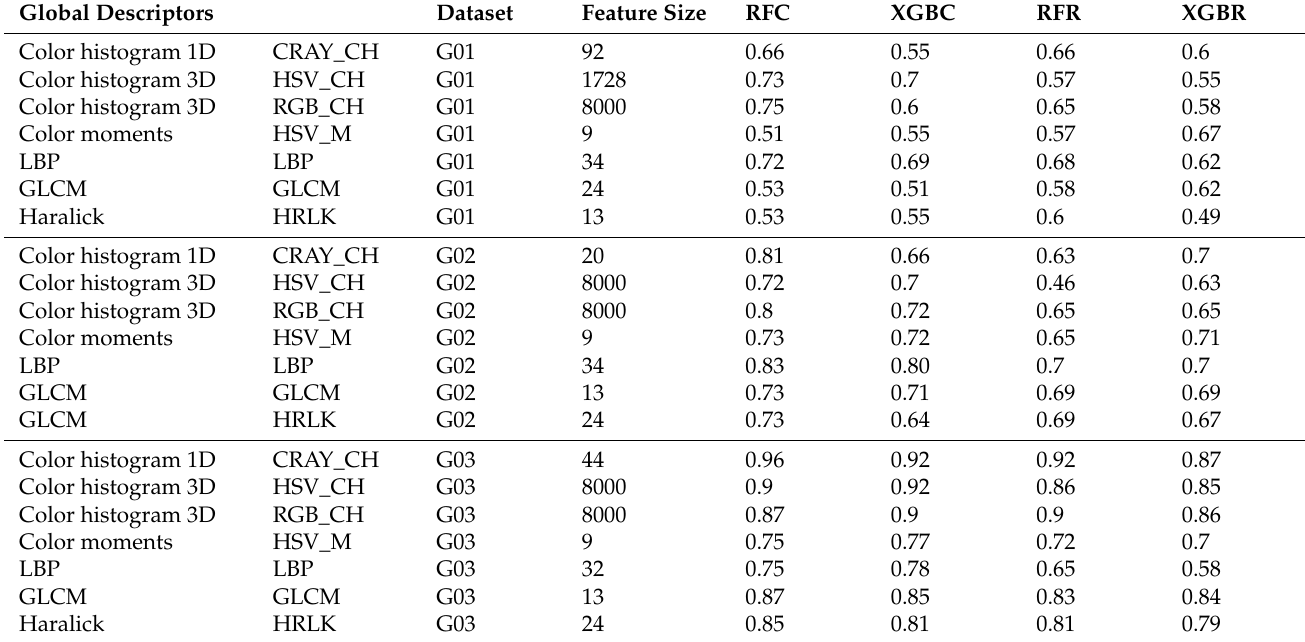
Table 1. Average f1-score performance of different classifier algorithms with global descriptors in 940 × 940 images.